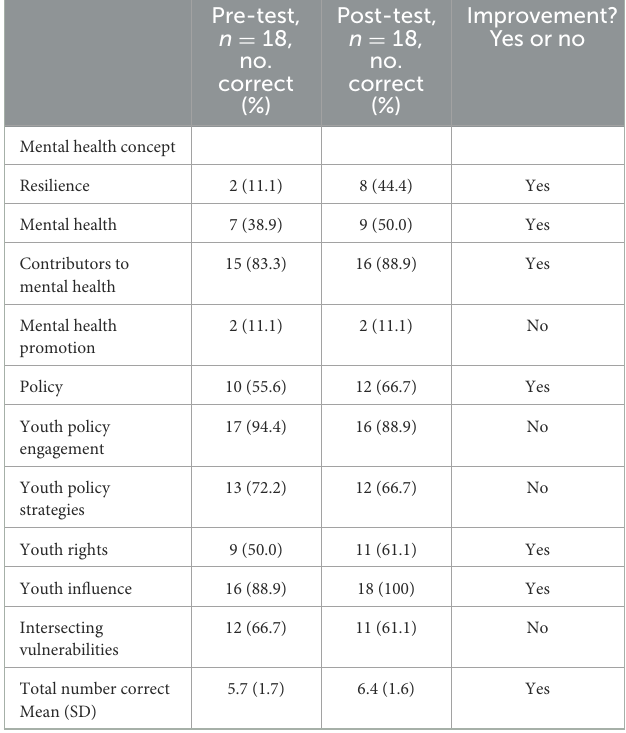
TABLE 3 Description of pre- and post-intervention knowledge